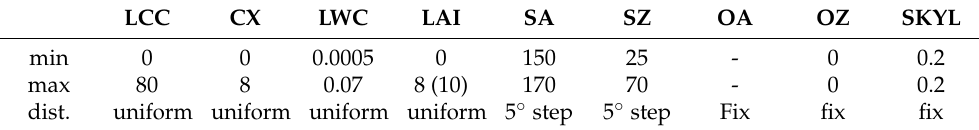
Table 1. Values of ProSail inputs common for all six crops of interest. LCC = leaf chlorophyll con- tent, CX = carotenoid content, LWC = leaf water content, LAI = leaf area index, SA = sun azimuth,